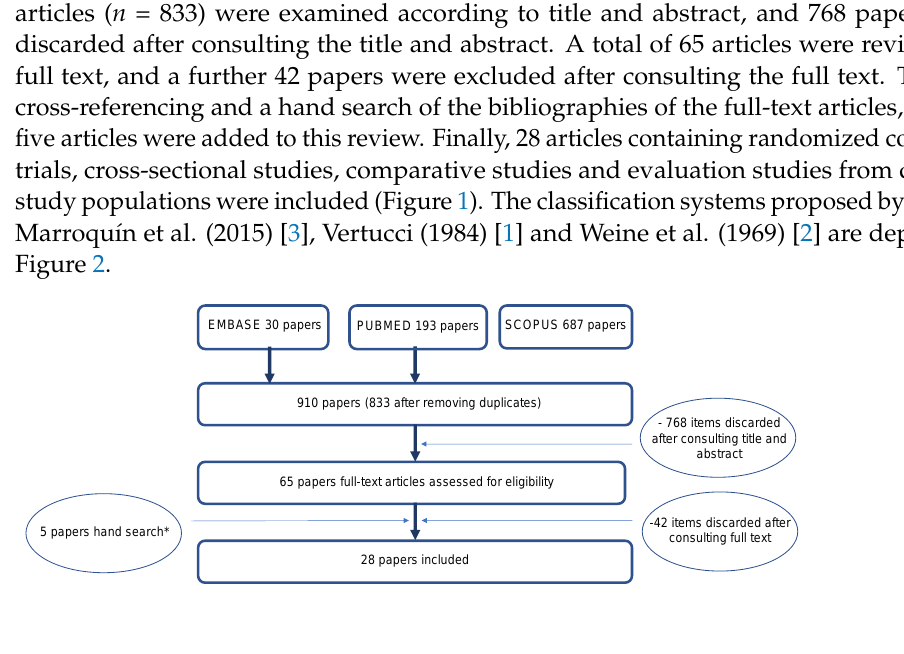
Figure 2. Classification systems proposed by Briseño-Marroquín et al. (2015) [3], Vertucci (1984) [1] and Weine et al. (1969) [2]. Table 1 shows detailed information on the articles: authors, year of publication, sample size, research methods used, number of roots and root canal configurations (RCCs) observed based on the classification systems by Vertucci [1], Weine et al. [2] and Briseño-Marroquín et al. [3].